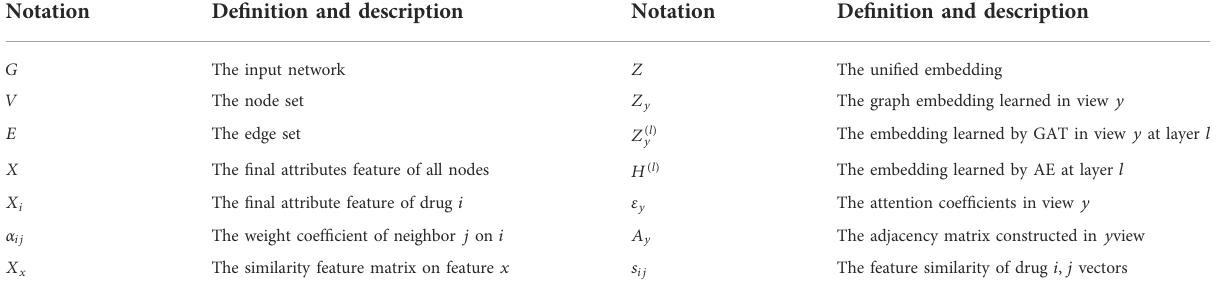
TABLE 1 The main notation and de fi